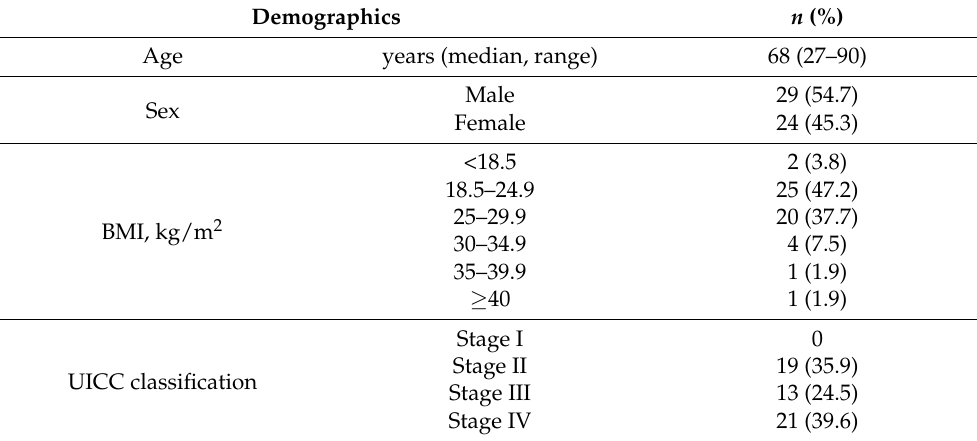
Table 2. Characteristics of patients in the validation